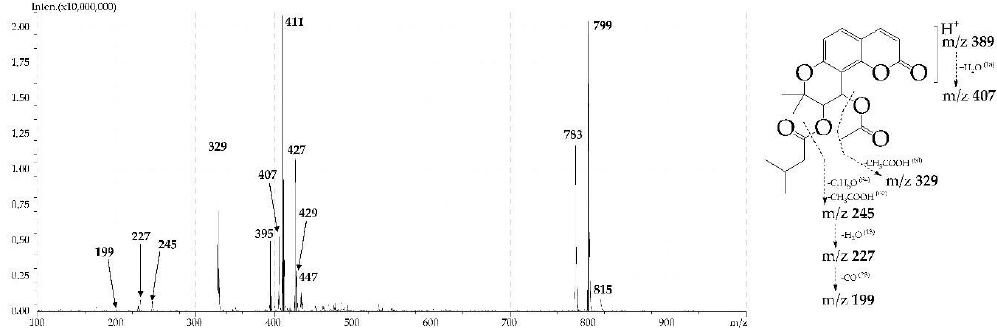
Figure 5. ESI-MS spectrum (positive ionization) and fragmentation path of khellactone 3′ - O -isovaleroyl- 4′ - O -acetyl ester (dihydrosamidin, 15 ). To facilitate the identification of components, reference compounds were used to identify twelve substances, including khellactone 4′ - O -methyl ester ( 4 ), khellactone 4′ - O -acetyl ester ( 6 ), khellactone 3′,4′ -di- O -acetyl ester ( 9 ), khellactone 4′ - O -angeloyl ester or d-laserpitin ( 11 ),